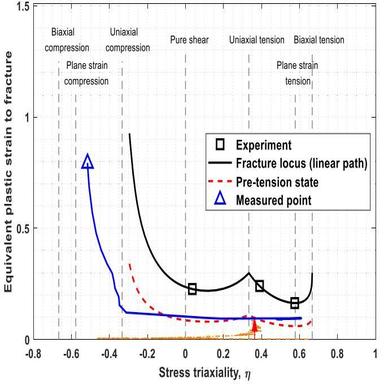
Compression test with pre-tensioned specimens.